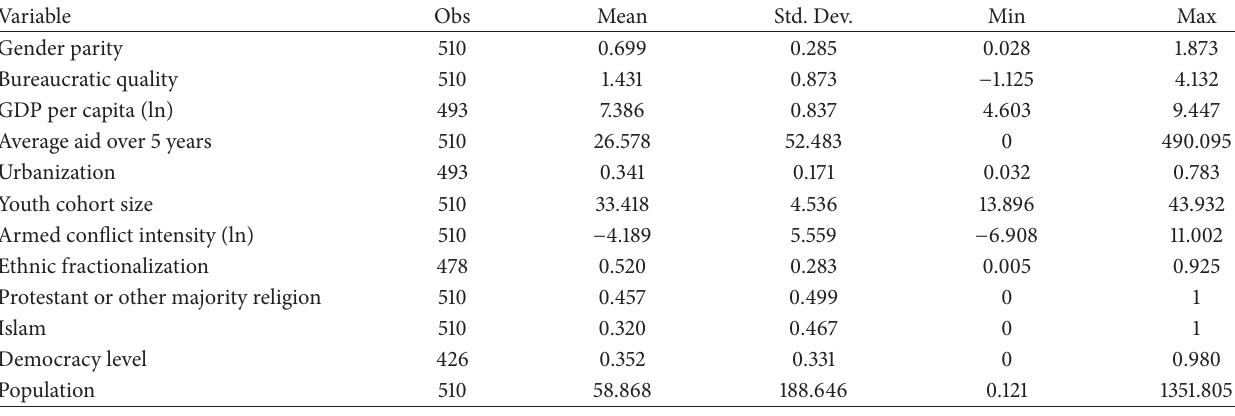
Table 6: Descriptive statistics, developing countries, 1970–2010.